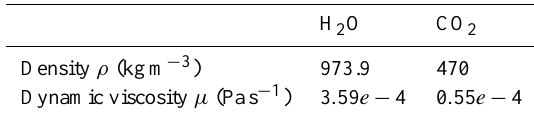
Table 1. Fluid properties representing supercritical CO 2 and H 2 O in the